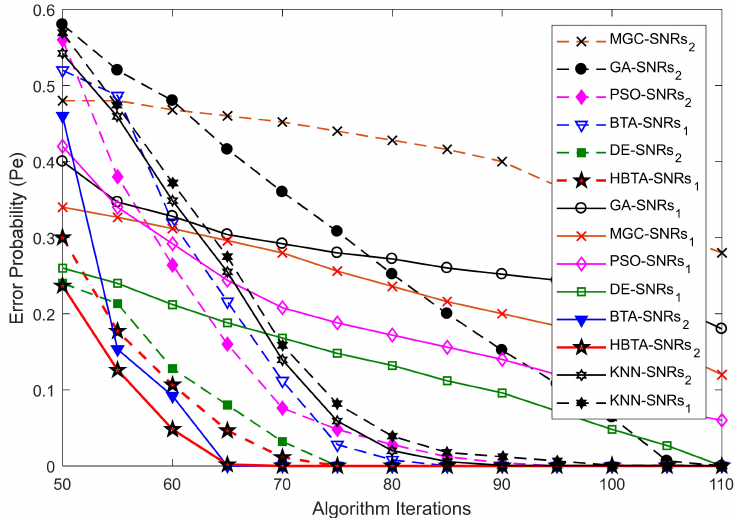
Figure 6. Error probability vs. iterations in the presence of AO-AOC users with SNRs 1 ( − 9.5 dB) and SNRs 2 ( − 0.5